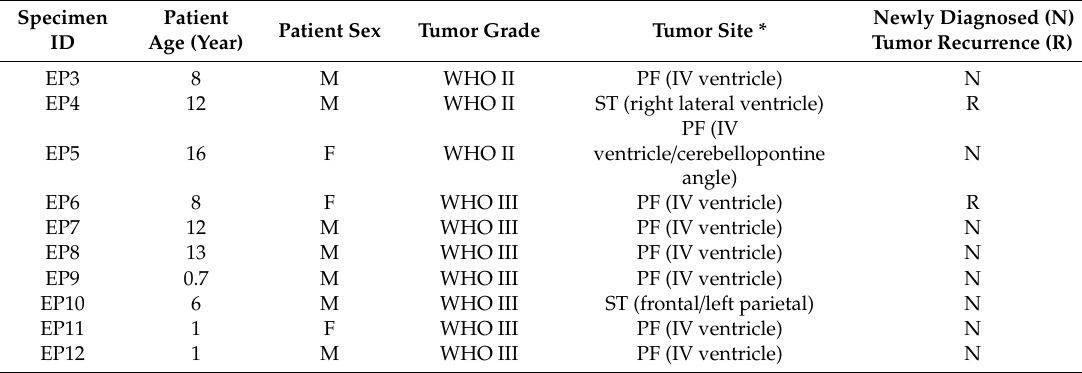
Table 2. Ependymoma tumor specimens